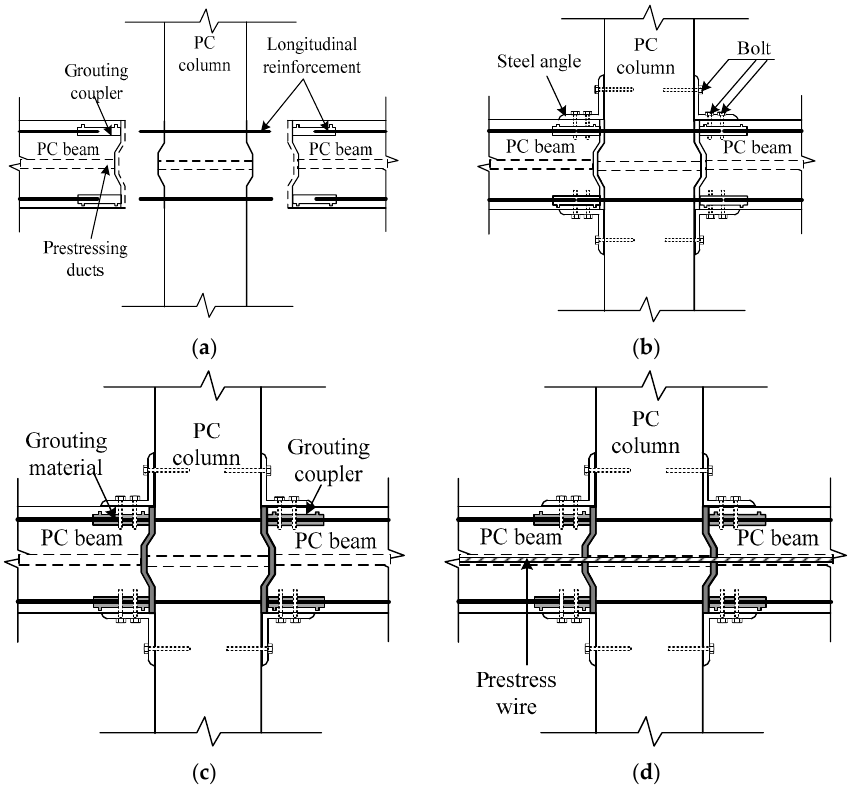
Figure 2. Assembly process for the HPC connection: ( a ) locations of the beam and column; ( b ) con- nection assembly; ( c ) grouting curing; ( d ) prestress tension.